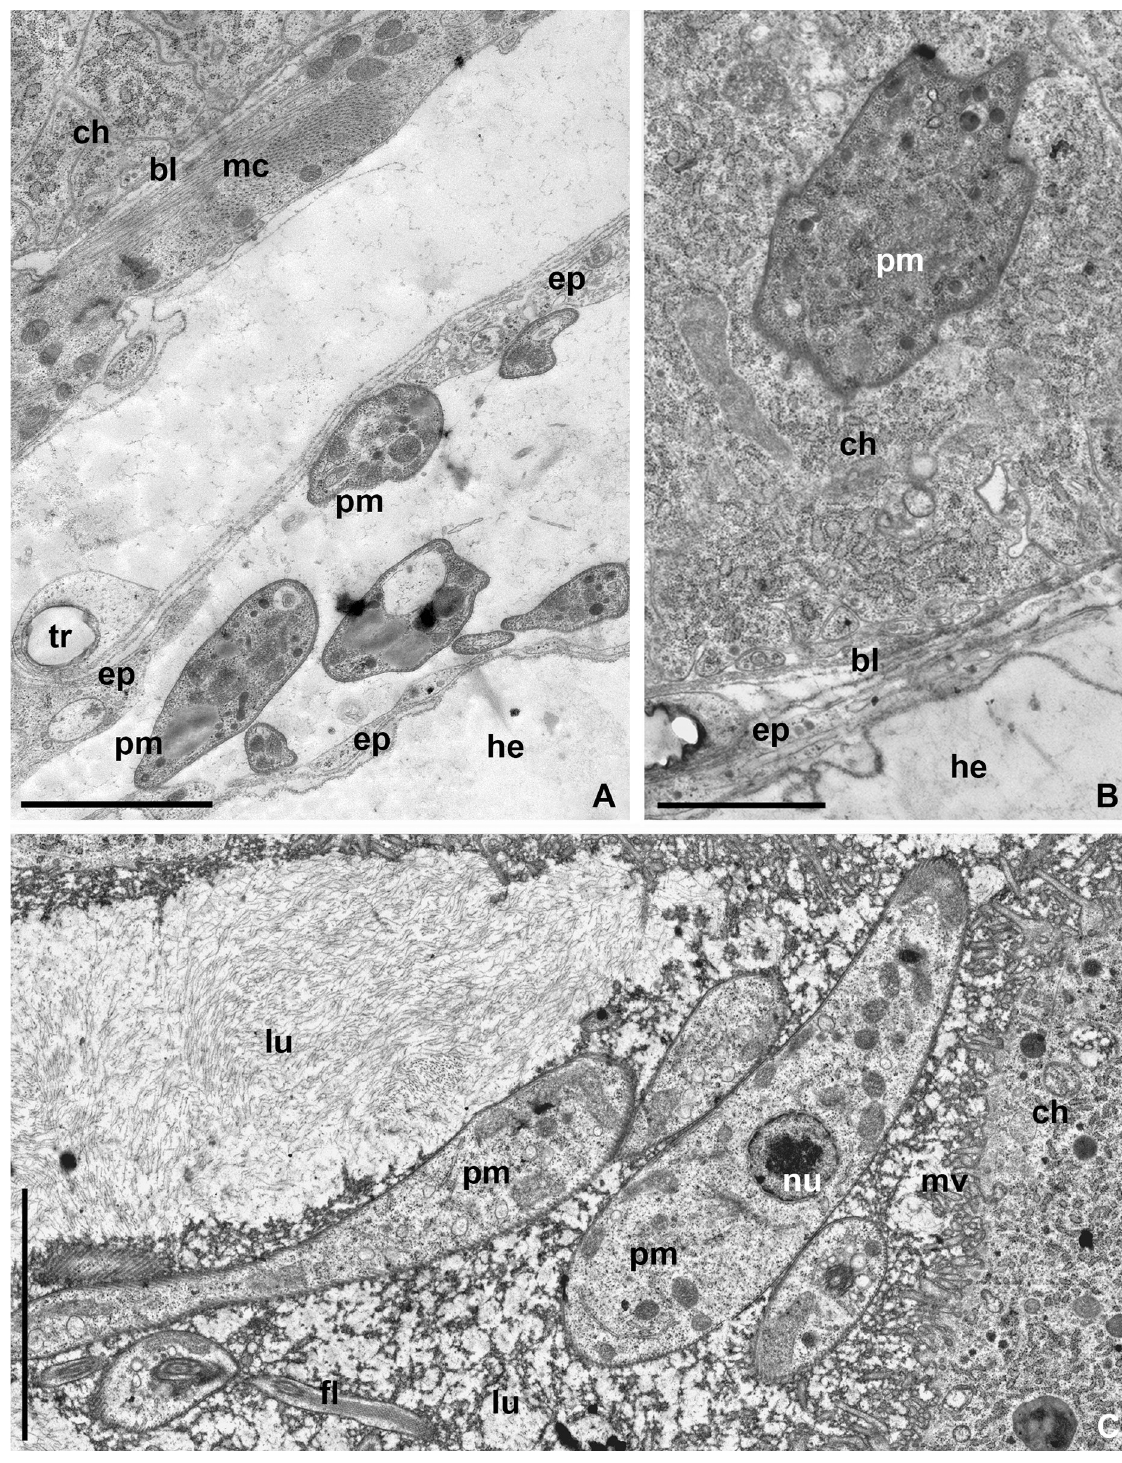
Fig 4. Phytomonas lipae in the salivary glands of C . marginatus (TEM). A.– Promastigotes of P . lipae in the coelomic epithelium; B. P . lipae in the cytoplasm of a salivary gland’s cell; C– Promastigotes in the lumen. bl –basal lamina; ch –host’s salivary gland cell; ep –coelomic epithelium; he –hemocoel; lu –lumen of the salivary gland; mc –muscle cells; mv –microvilli; tr –trachea. Other abbreviations are as in Fig 3. Scale bars: 2 μ m ( A, C ); 2.5 μ m ( B ).